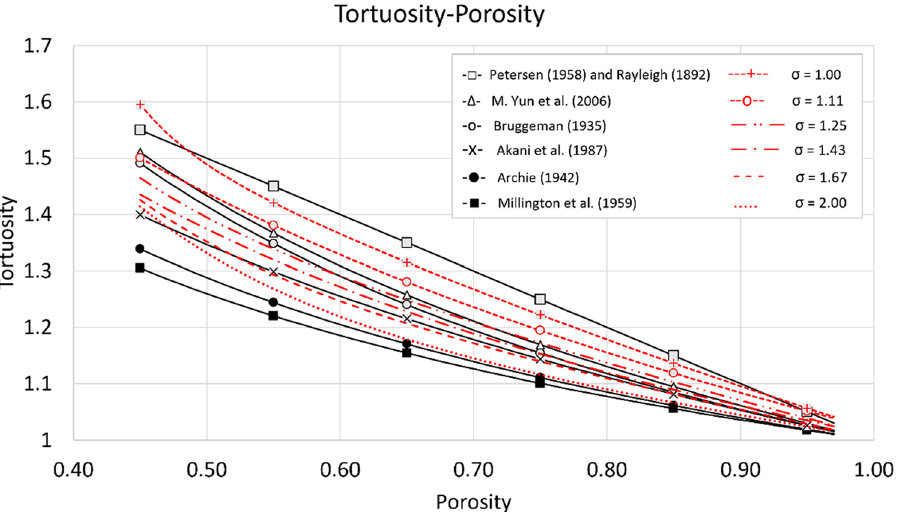
Figure 14. Comparison between tortuosity-porosity correlations from previous studies (black markers and lines) and correlations proposed in the current study (red markers and lines).